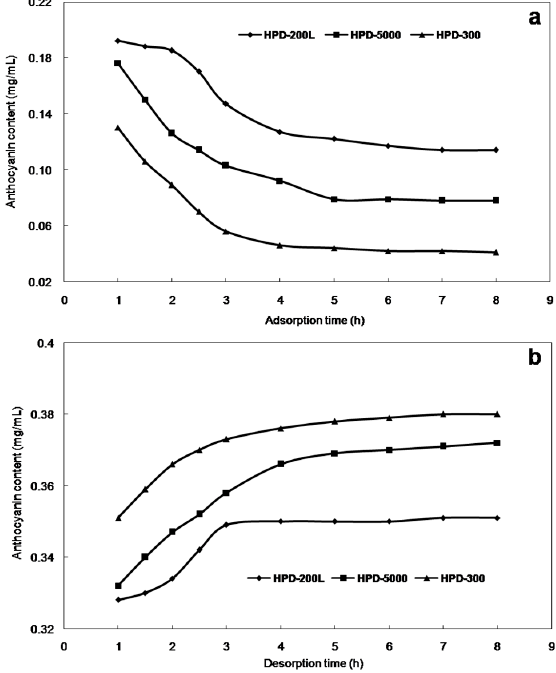
Figure 1. The adsorption ( a ) and desorption ( b ) kinetic curves for S. chinensis anthocyanins on HPD-300 resin.